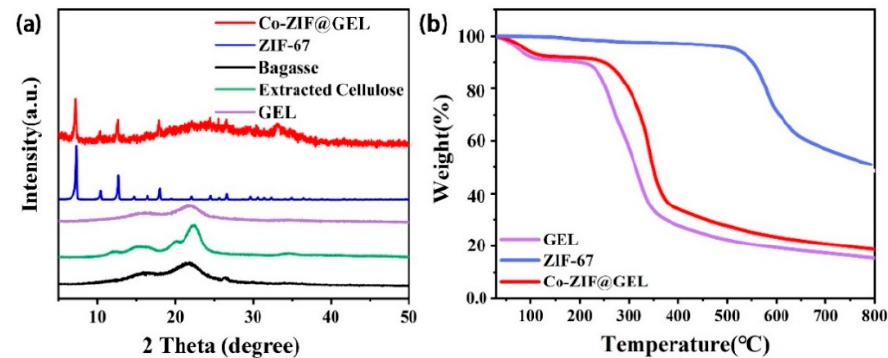
Figure 3. X-ray powder diffractograms of ( a ) Extracted cellulose from bagasse, ZIF-67, GEL and Co-ZIF@GEL; ( b ) TG curves of ZIF-67 and Co-ZIF@GEL.